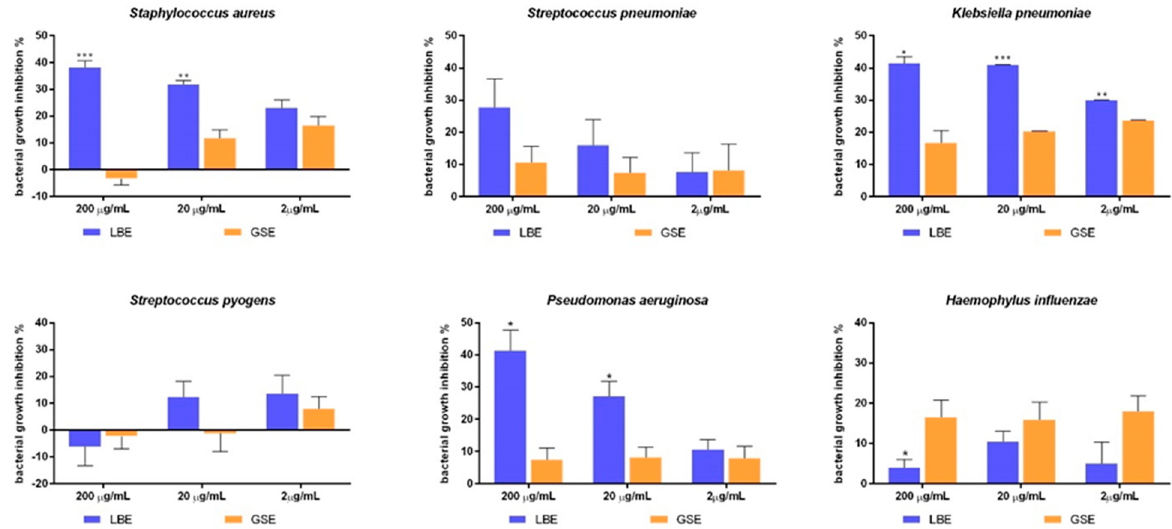
Figure 2. Bacterial growth inhibition % of respiratory tract pathogens treated with larch bark extract (LBE; blue bars) and grapefruit seed extract (GSE; orange bars) at different concentrations (200-20-2 µg/mL). Results are the mean ± SD of n = 3 experiments. * p < 0.05; ** p < 0.01; *** p < 0.001 vs. bacteria treated with GSE.